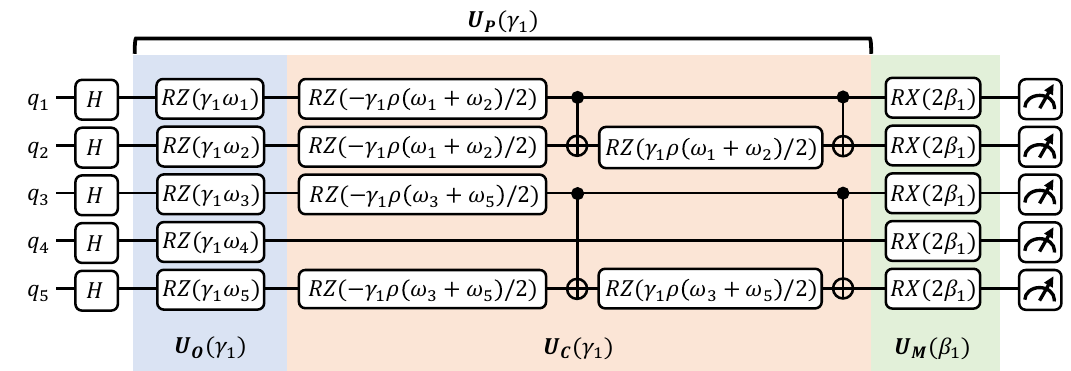
Figure 5. Proposed QAOA 1 circuit for MWIS with 5 qubits: The qubit q j corresponds to j th node. γ 1 and β 1 are circuit parameters, and w j is the weight of j th node. Each qubit is initialized to the uniform superposition state via the Hadamard gate. The objective operator U O ( γ 1 ) is implemented using the RZ ( γ 1 w j ) gates. The constraint operator U C ( γ 1 ) is implemented as a combination of